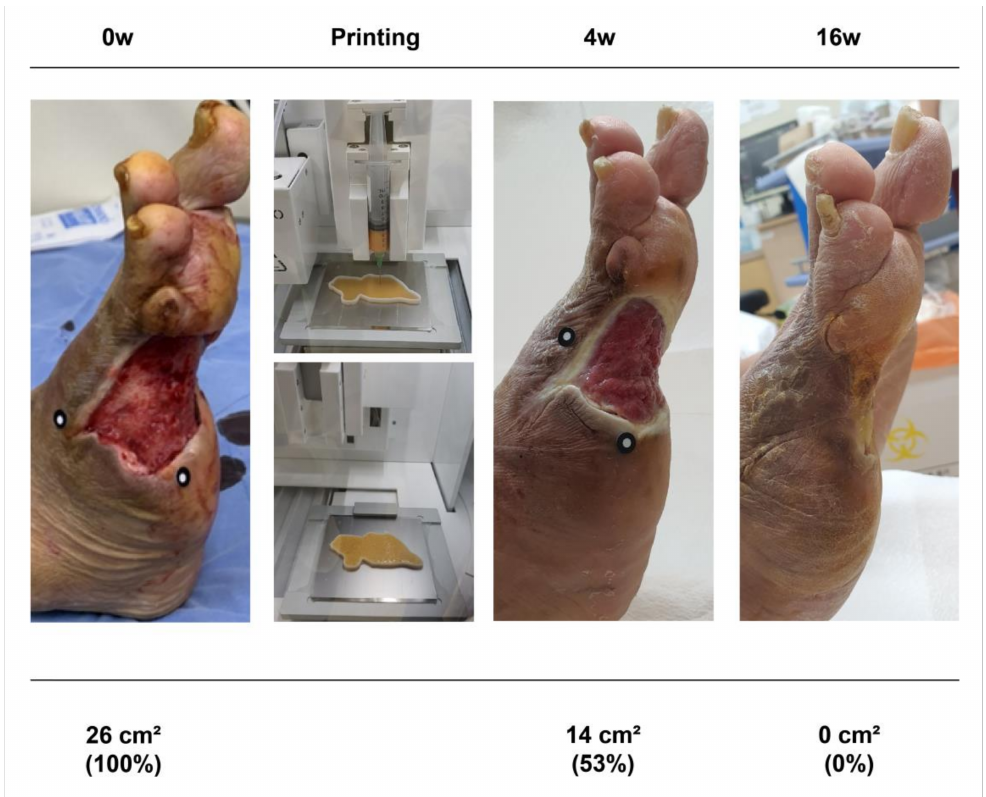
Figure 5. A 70 year old man with diabetes mellitus had a nonhealing ulcer on his right foot for 8 weeks. A micronized adipose tissue niche was applied to the